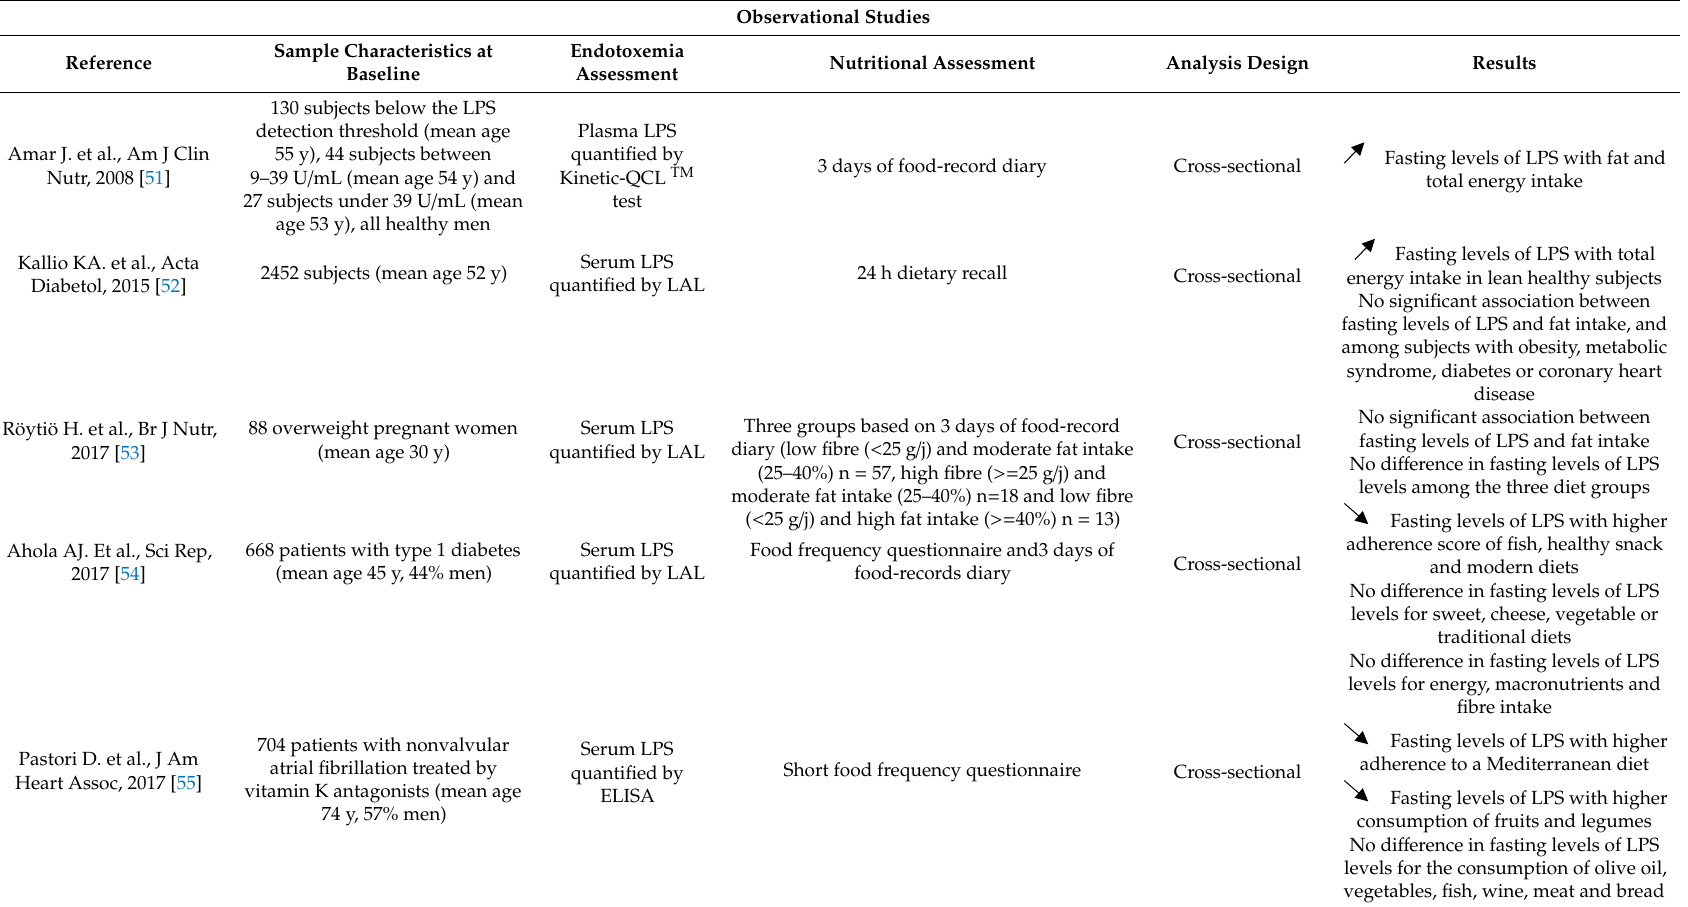
Table 1. Selective evidence on the association between a single high-fat meal and metabolic endotoxemia.